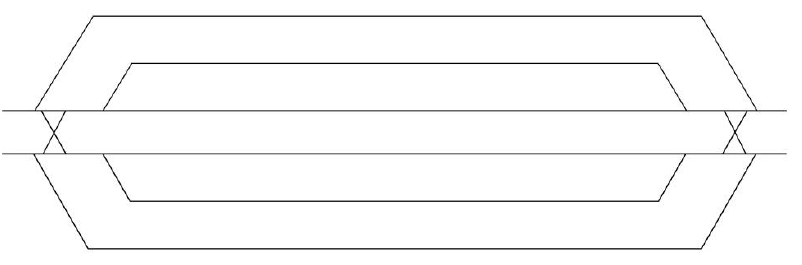
Figure 14. The new track layout diagram proposal.